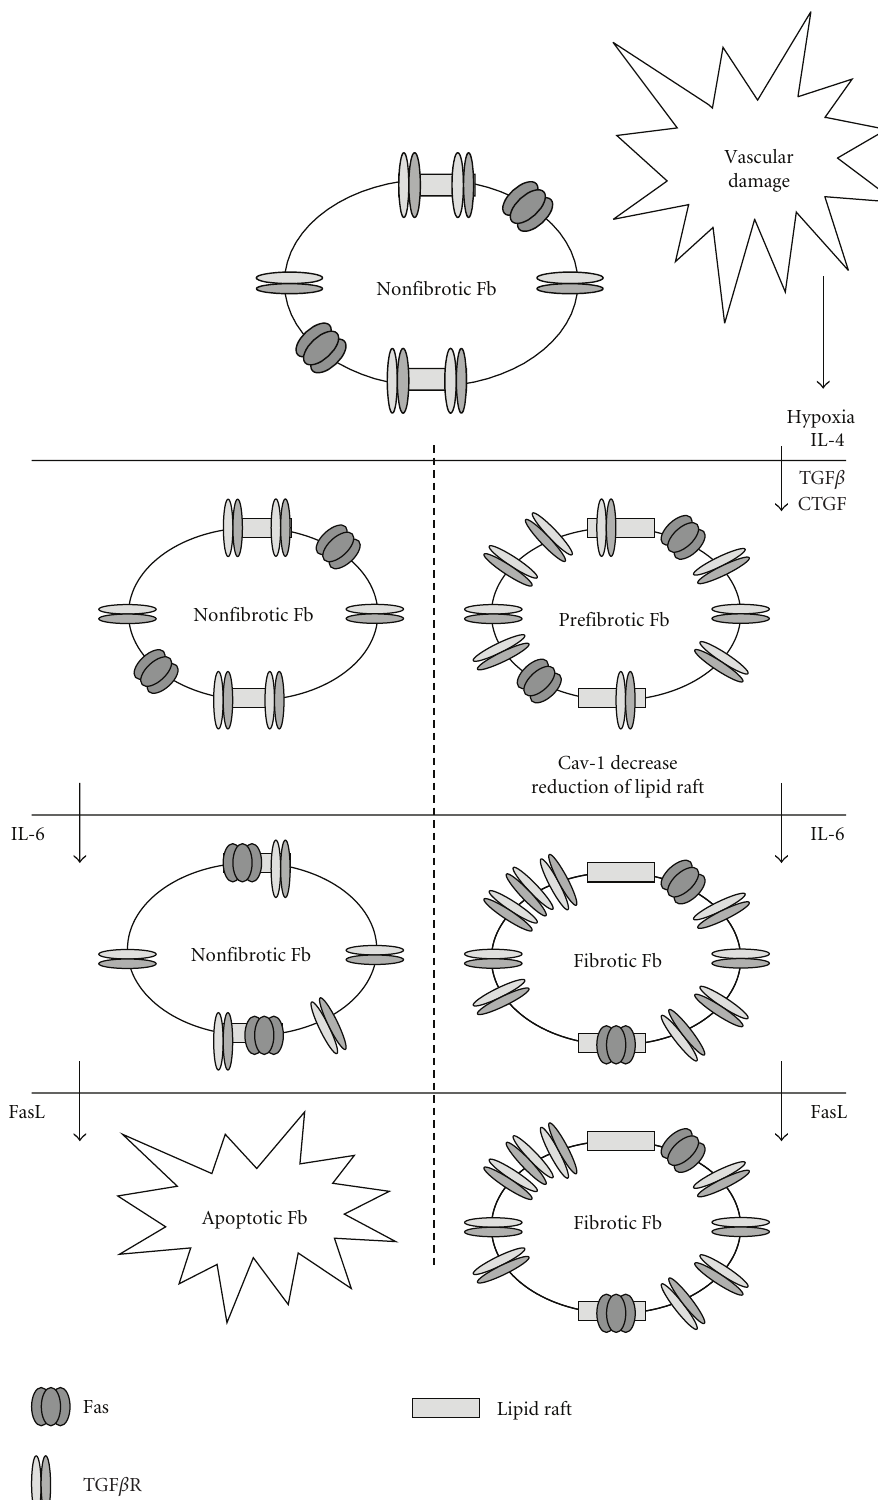
Figure 2: Hypothetic mechanism of FasL/IL6 selection of prefibrotic fibroblast in scleroderma lesions. After vascular damage, various factors are directly secreted by apoptotic endothelial cells or are secreted by macrophages, T cells, and fibroblasts in response to endothelial cell deaths and subsequent hypoxia. More proximal cells become prefibrotic by increasing their response to TGF β . IL-6 secretion induces a more fibrotic phenotype for cells and increases apoptosis-resistant feature of profibrotic ones. FasL secreted by infiltrating cells kills nonfibrotic fibroblast with low or none e ff ect on fibrotic cells. ECM is then deposited in excess and organ